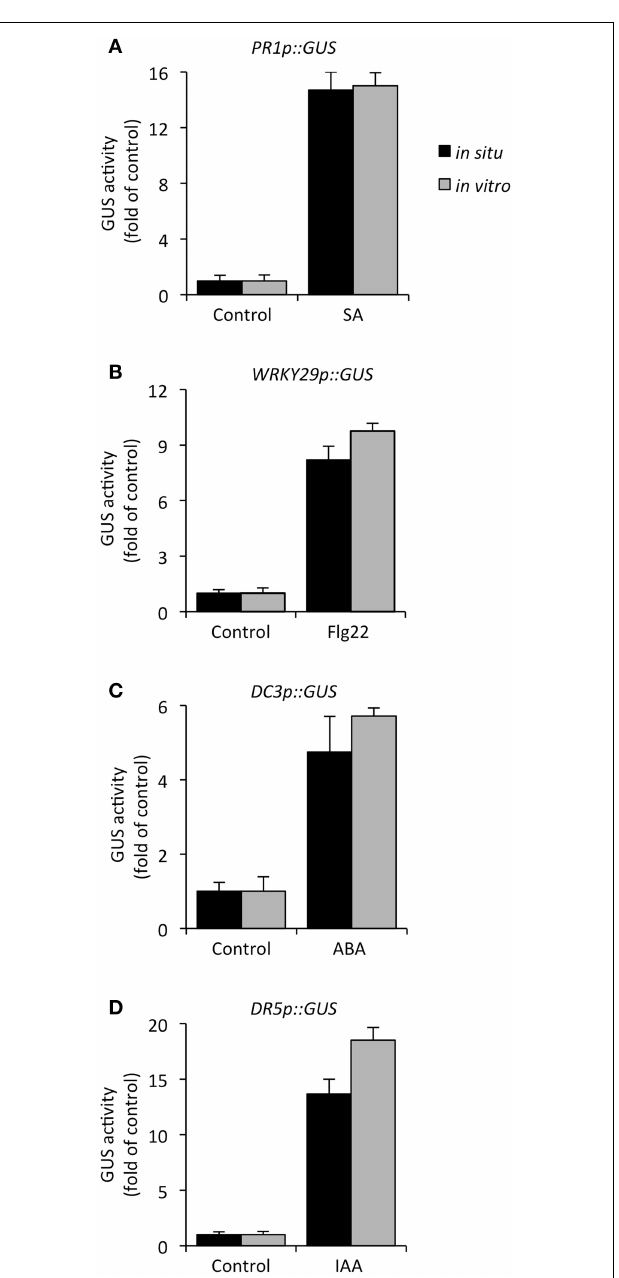
FIGURE 3 | Comparison of induced expression of diverse promoter–GUS reporter genes as determined by in situ and in vitro GUS assays. Twelve-day-old transgenic Arabidopsis seedlings were appropriately treated to obtain high reporter gene expression: (A) PR1p::GUS (200 μ M SA, 24h), (B) WRKY29p::GUS (1 μ M flg22, 4h), (C) DC3p::GUS (100 μ M ABA, 24h), and (D) DR5p::GUS (5 μ M IAA, 4h). GUS activity in situ (black bars) was determined after incubation of whole seedlings with the substrate 4-MUG (1mM) for 2h and it is compared to GUS activity (initial rate) determined in vitro (gray bars) using protein extracts prepared from seedlings that were treated identically. For better comparison, the resulting activities in situ [relative light units (RLU) per assay] and in vitro (pmol min − 1 mg − 1 protein) are normalized to untreated control samples, thus showing fold of induction in response to treatment. All values represent the mean ( ± SD) of four biological